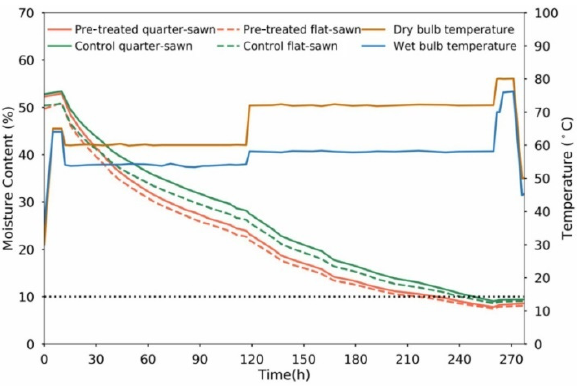
Figure 2. Conventional drying curves of microwave-pre-treated and control wood samples [43]. Table 1. MC and residual stress index of microwave-pre-treated and control samples after drying.